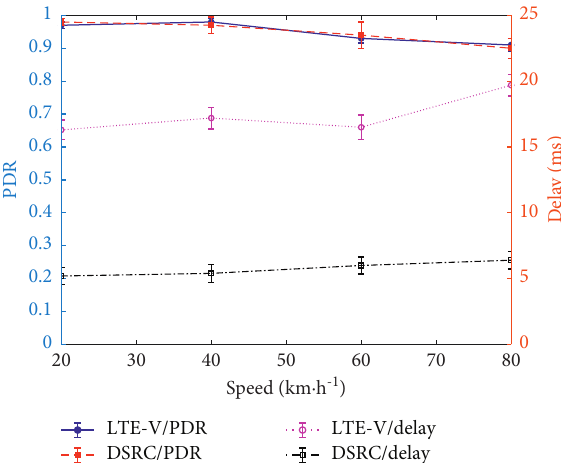
Figure 14: The results of feasibility for high-speed vehicle running in the car-following